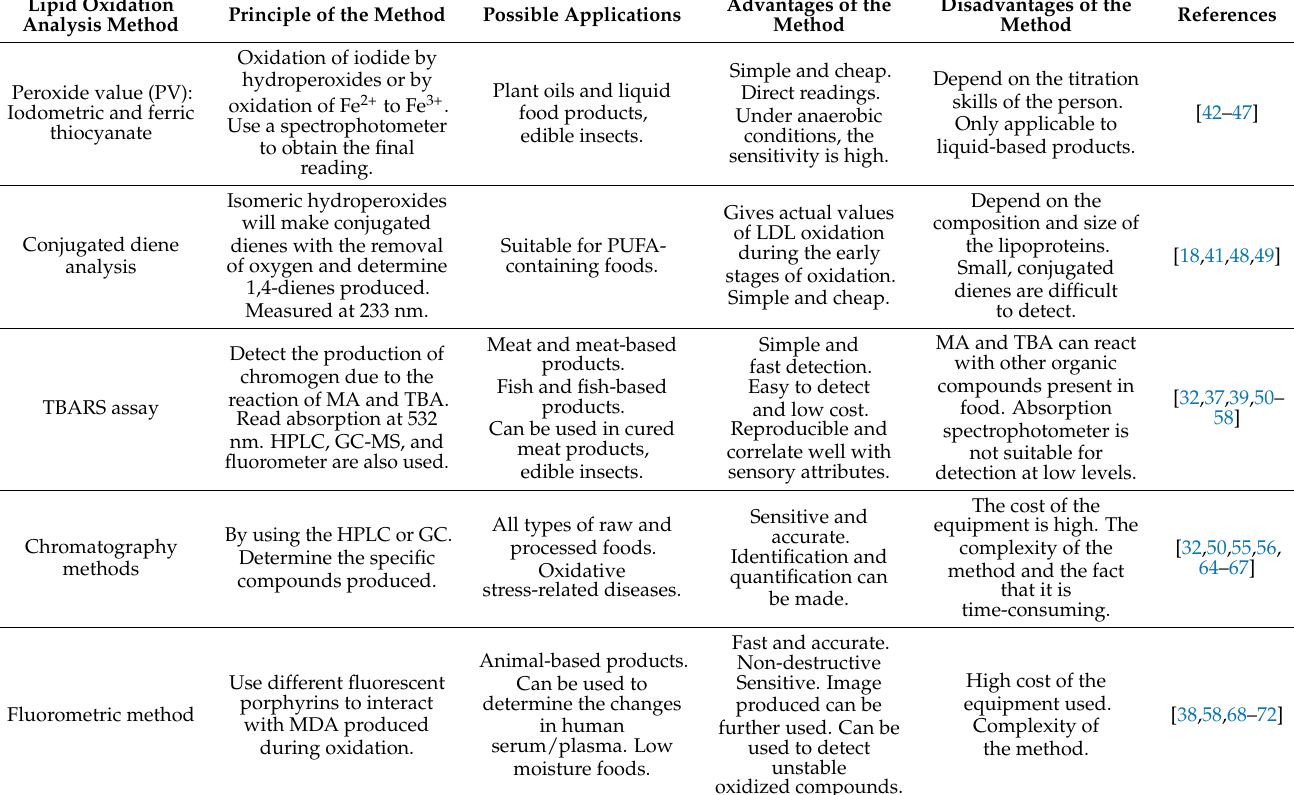
Table 1. Summary of the common methods used in lipid